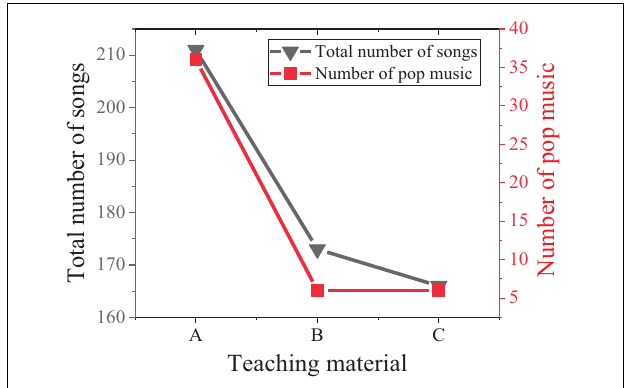
FIGURE 1 | Comparison of the total number of music and popular music in the three teaching materials.